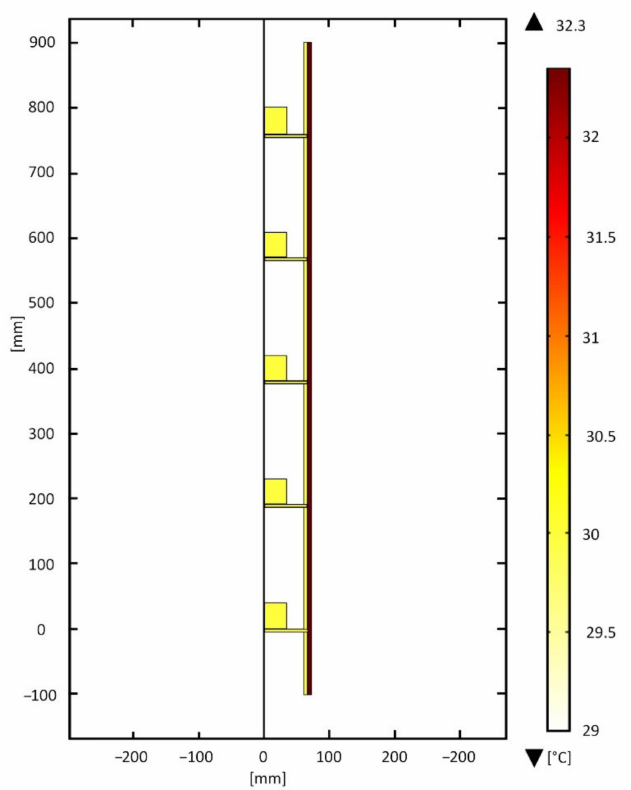
Figure 6. Spatial temperature distribution, data from COMSOL